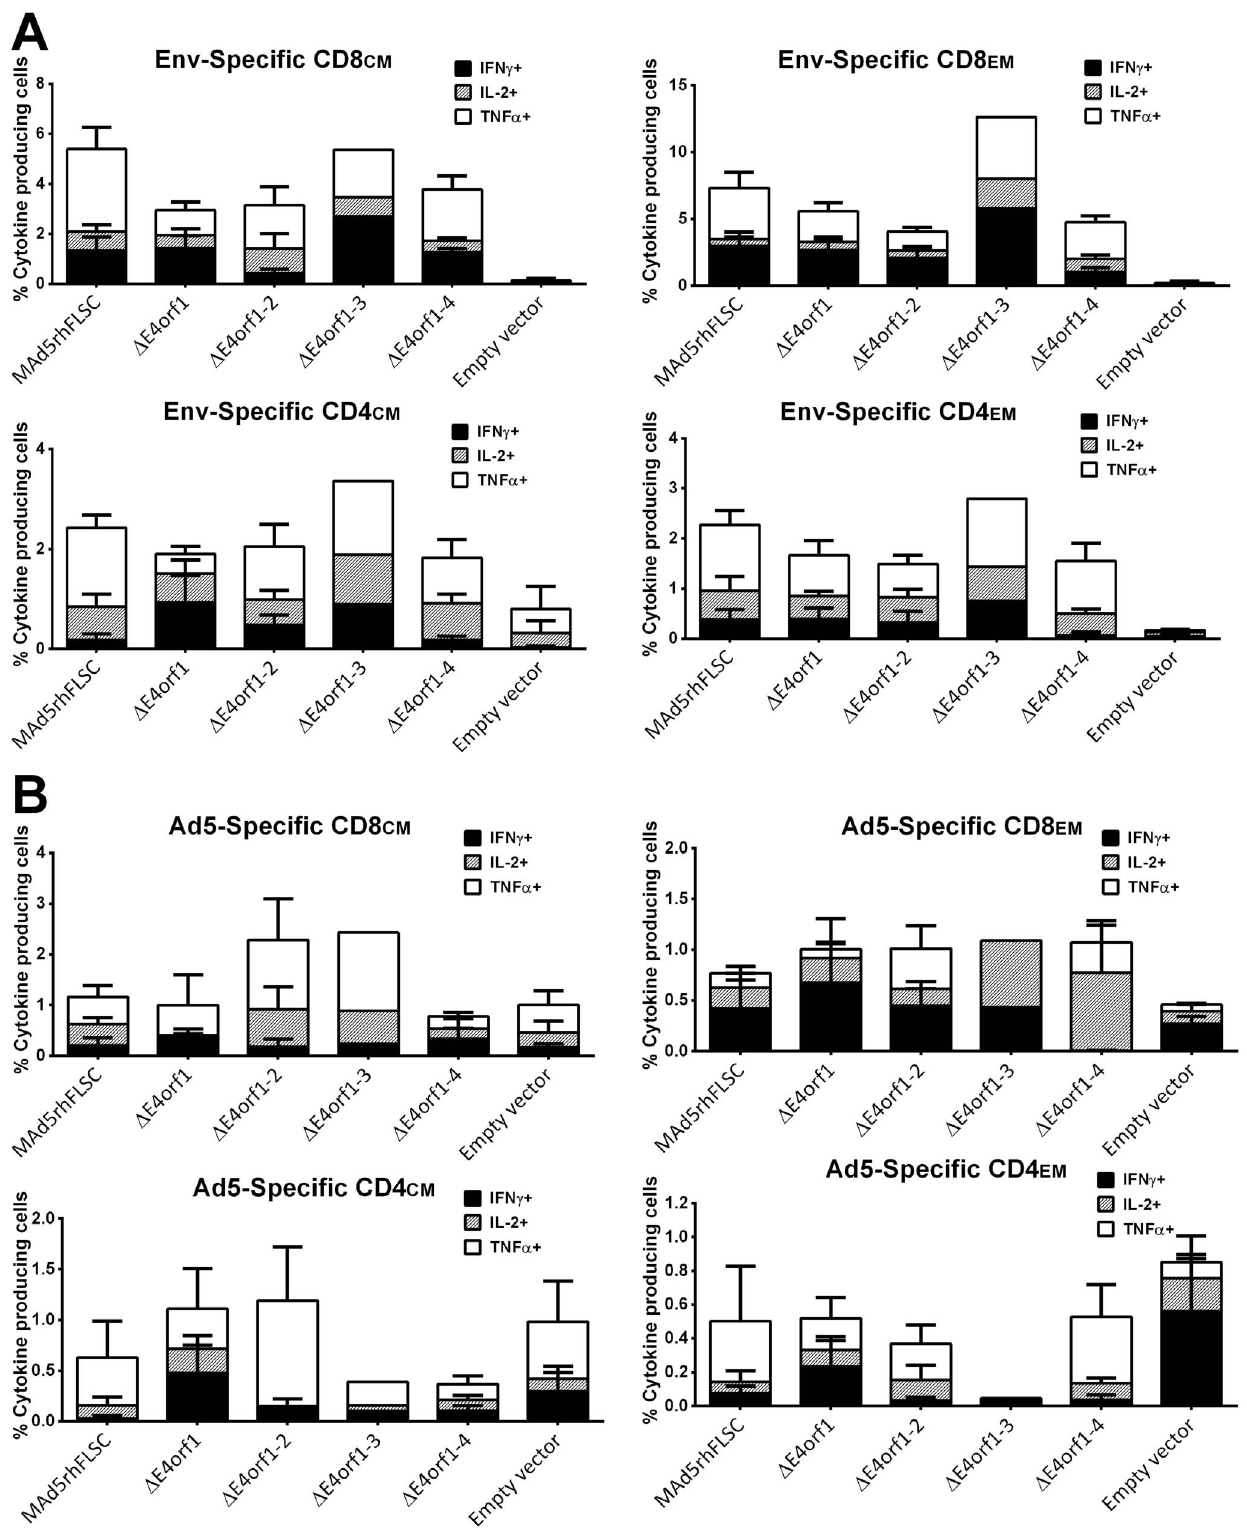
Figure 8. Deletion of E4orf1 through E4orf4 does not affect transgene or Ad5-specific cellular responses. ( A–B ) Intracellular cytokine staining of splenocytes with stacked responses for Env- or Ad5-specific CD8 and CD4 CM or EM T cells secreting IFN c , IL-2, and TNF a . (A) No differences were observed between the parent and the E4 -deleted viruses (p . 0.05). Values of the five vaccinated groups were significantly different from those of the empty vector group for Env-specific CD8 CM and CD8 EM T cells (p , 0.001 for both) and for Env-specific CD4 EM T cells (p , 0.002) but not for Env-specific CD4 EM T cells (p . 0.05). (B) No differences were observed between the parent and the E4-deleted viruses for the Ad5-specific